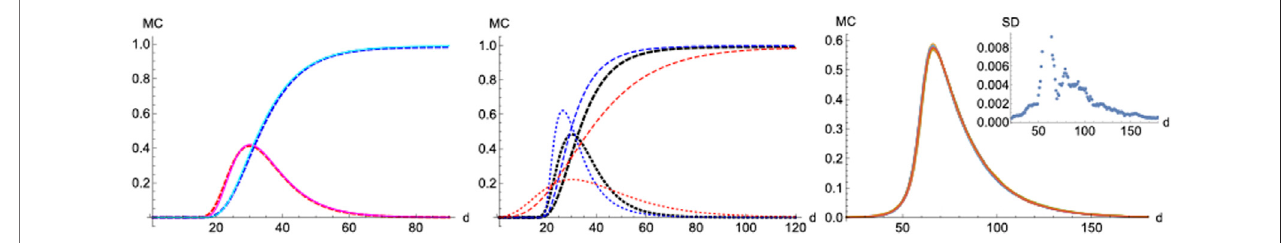
FIGURE 11 | Monte-Carlo simulations. Left panel: MC (continous) vs SIR (dashed). N (cid:2) 10000. Red/Magenta: infected. Blue/Cyan: removed. Parameters used in MC are: p i (cid:2) 0 . 5*i ( t ) , p r (cid:2) 0 . 1. Parameters used in SIR are: τ 0 (cid:2) 2, τ 1 (cid:2) 8. Middle panel: various MC scenarios for infected (dotted) and removed (dashed). Thick black: probabilitiesasinleftpanel.Blue:nearest-nextneighborsincreasedprobabilityofinfectionincreasesto p i (cid:2) 0 . 75 i ( t ) .Red:bothprobabilitiesforinfectionandremovalare kept constant values, p i (cid:2) 0 . 1 and p r (cid:2) 0 . 05. Right panel: average and standard deviation (inset) of 10 random realizations for p i (cid:2) 0 . 2*i ( t ) (double for nearest- neighbors infections) and, p r (cid:2) 0 . 05.